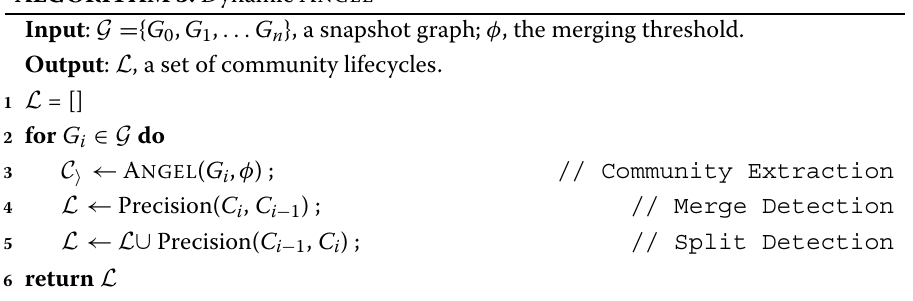
ALGORITHM 3: Dynamic A